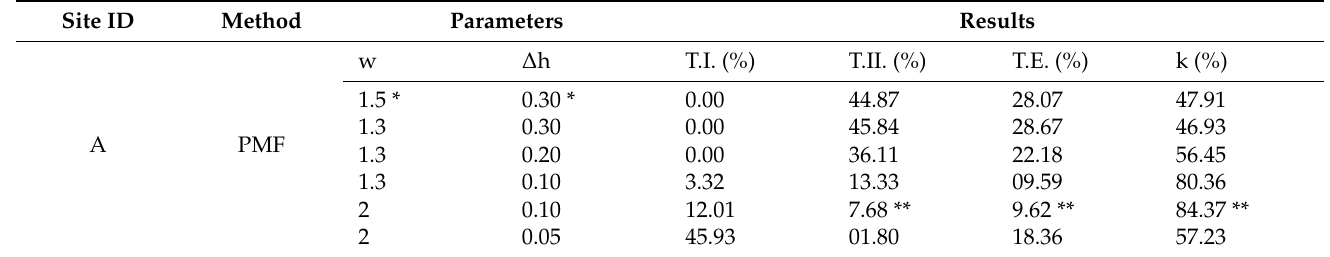
Table 5. PMF ground classification error metrics and kappa coefficients for different parameter